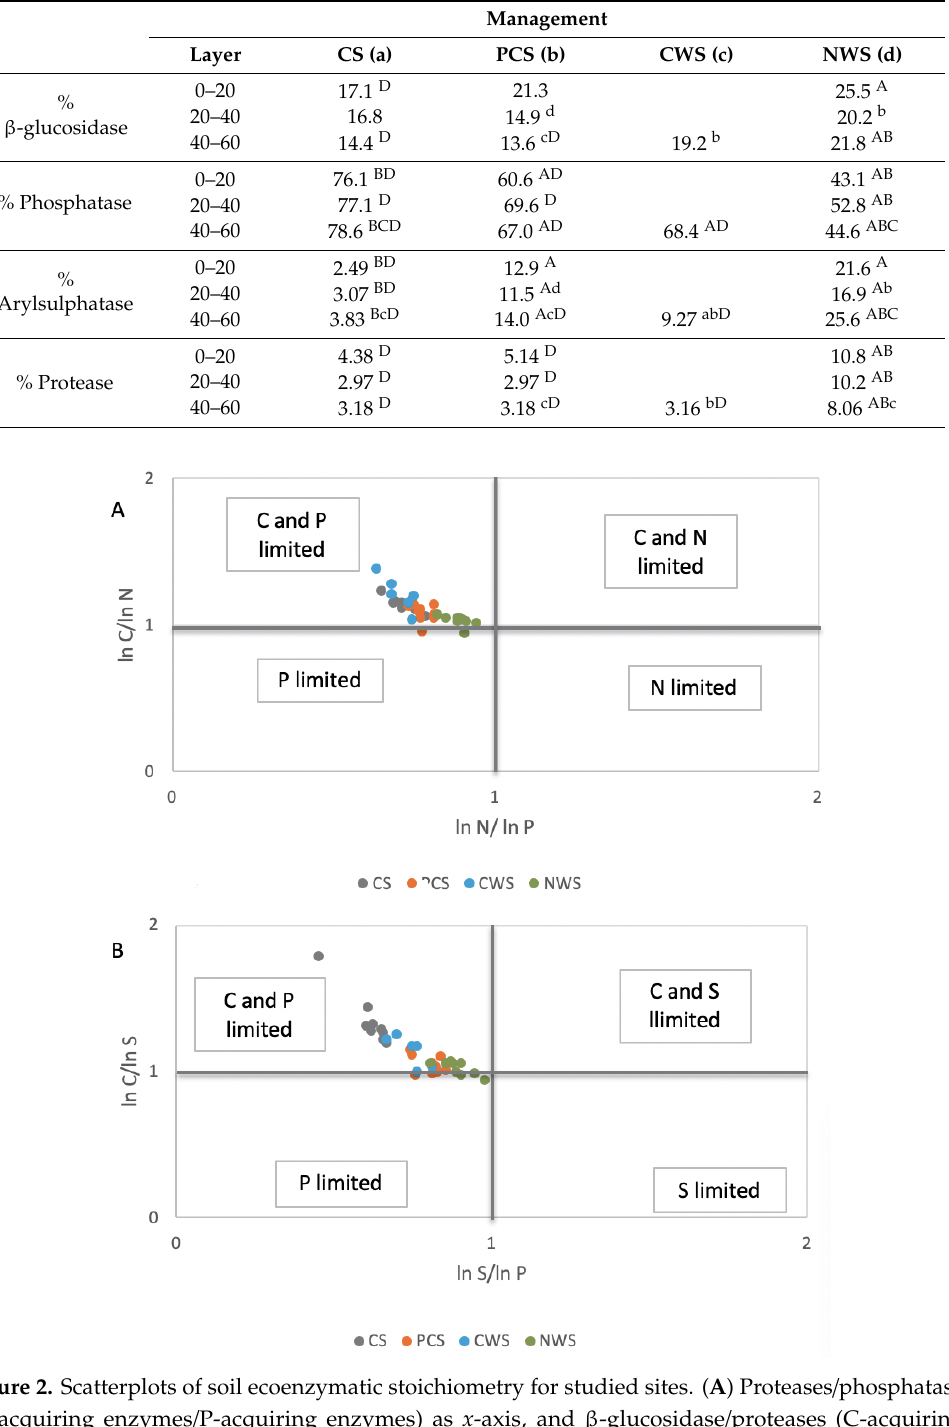
Table 4. ANOVA of soil enzyme activities expressed in percentage. Statistically significant di ff erences between the respective sites and depths are indicated by superscript indices that denote the significantly di ff erent site: a = CS; b = PCS; c = CWS; d = NWS. Statistically significant di ff erences, with p < 0.01, are indicated by uppercase letters and those with 0.01 < p < 0.05 are indicated by lowercase letters.